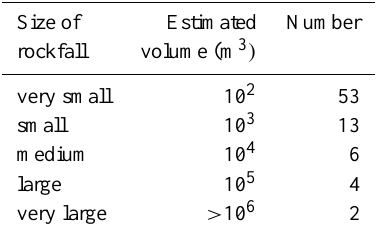
Table 2. Distribution of rockfalls according to their